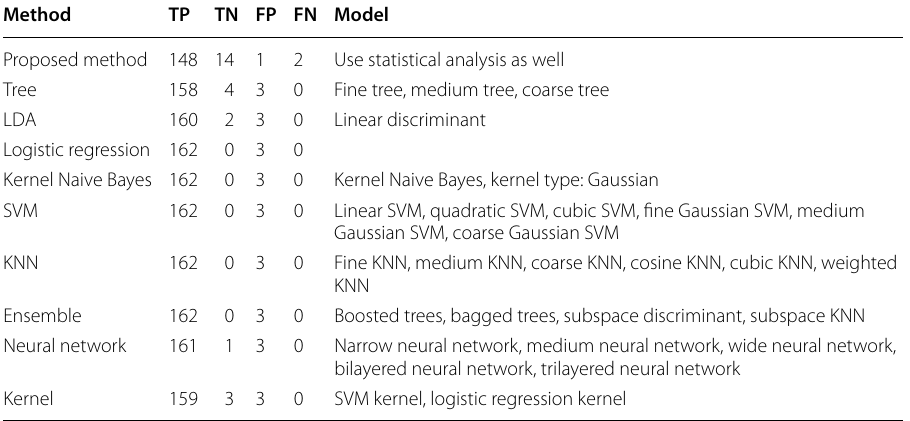
Table 7 Comparison with other machine learning